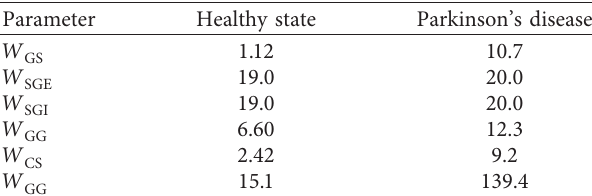
Table 2: Connection weights between neurons in different states.